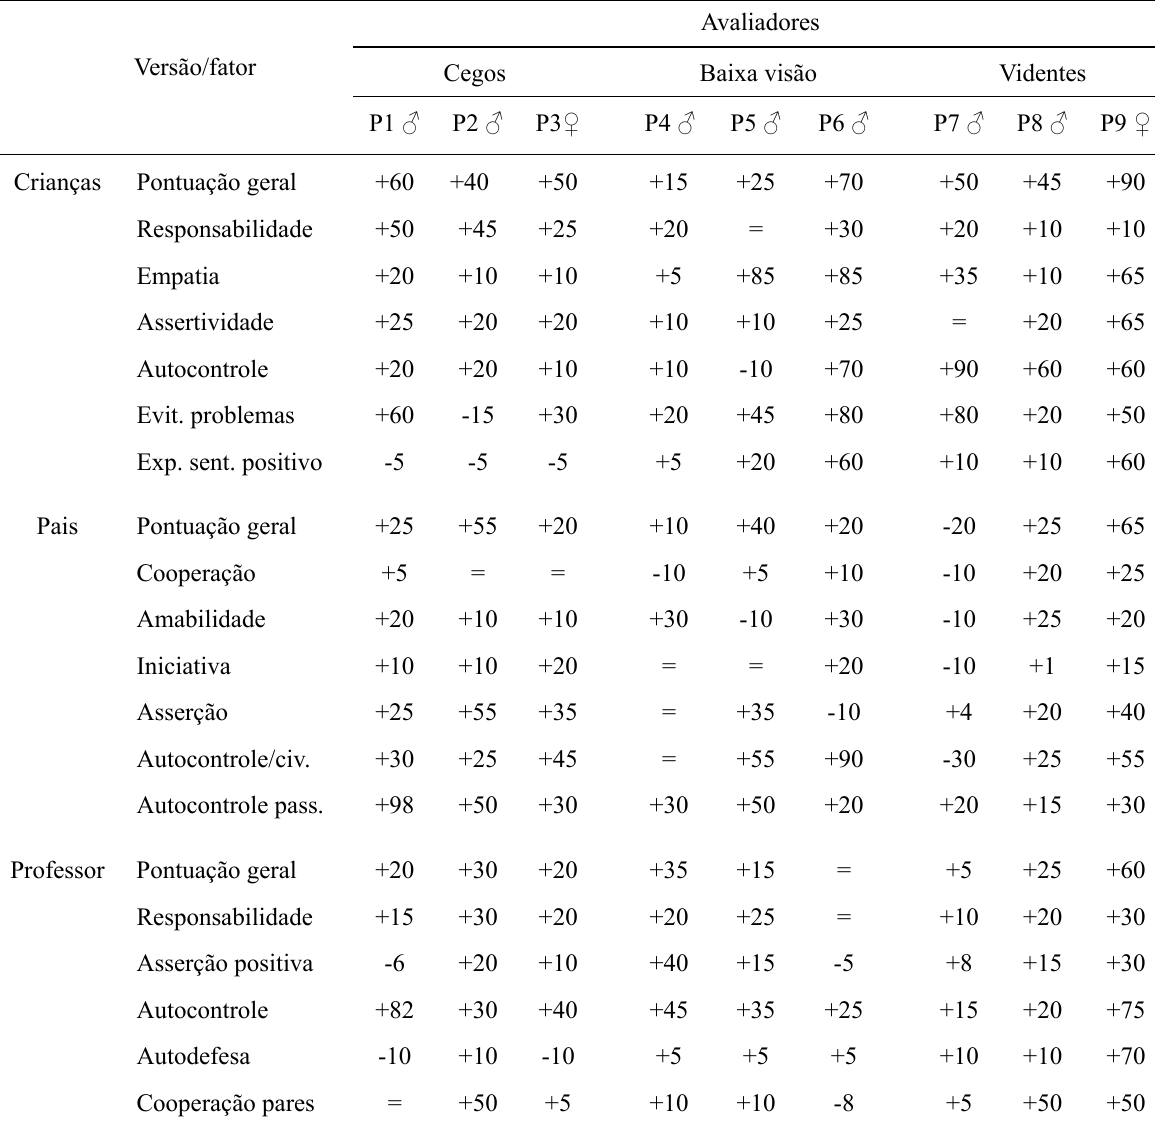
Diferença entre Pré-Teste e Pós-Teste na Pontuação Geral e por Fatores de Habilidades Sociais das Crianças